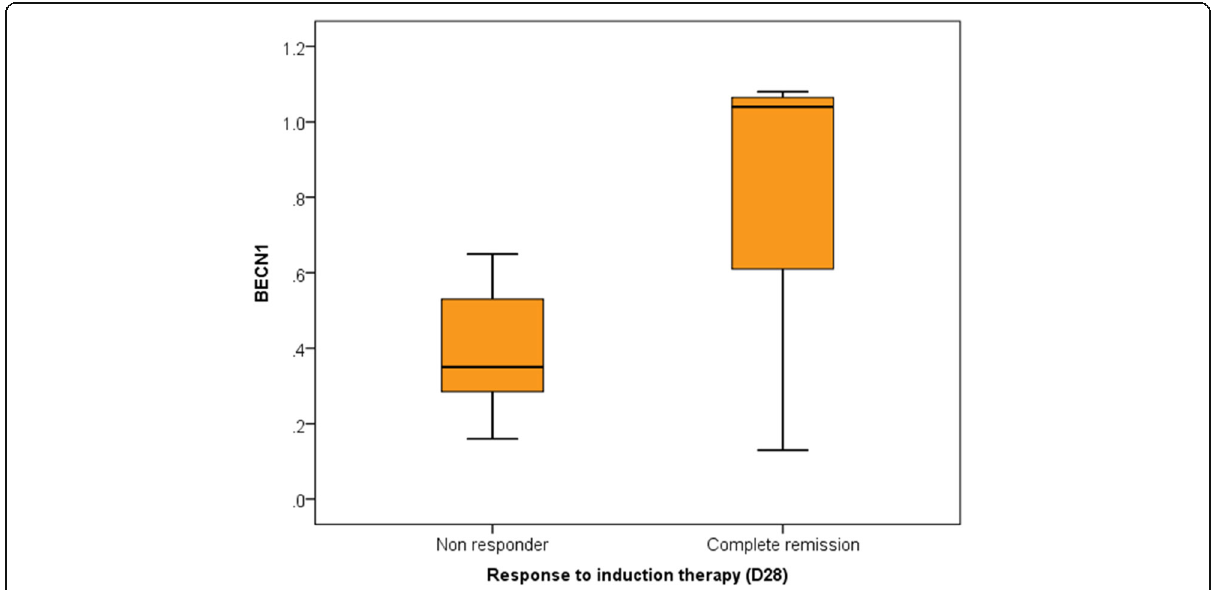
Fig. 2 Comparison between responders (complete remission) and non-responders regarding BECN1 gene expression